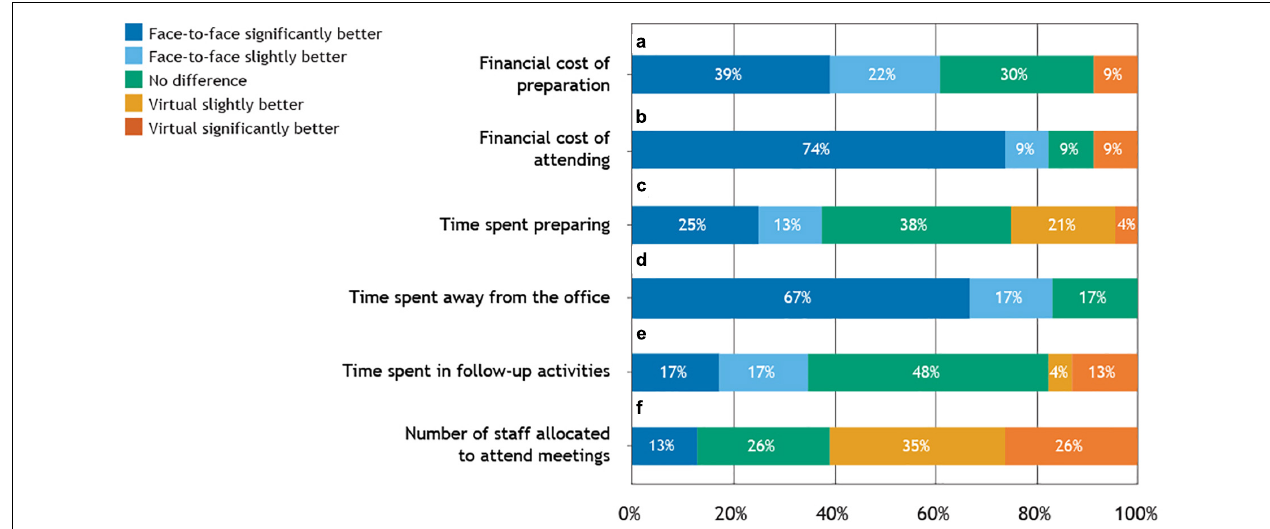
FIGURE 6 | Responses ( n = 24) to Did you use more organizational resources for face-to-face or virtual fisheries meetings?